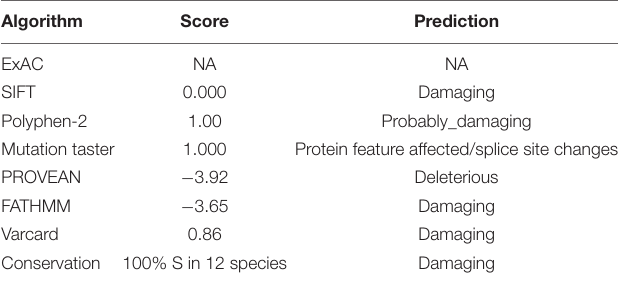
TABLE 1 | Overview of the ARSE mutation c.265A > G in silico